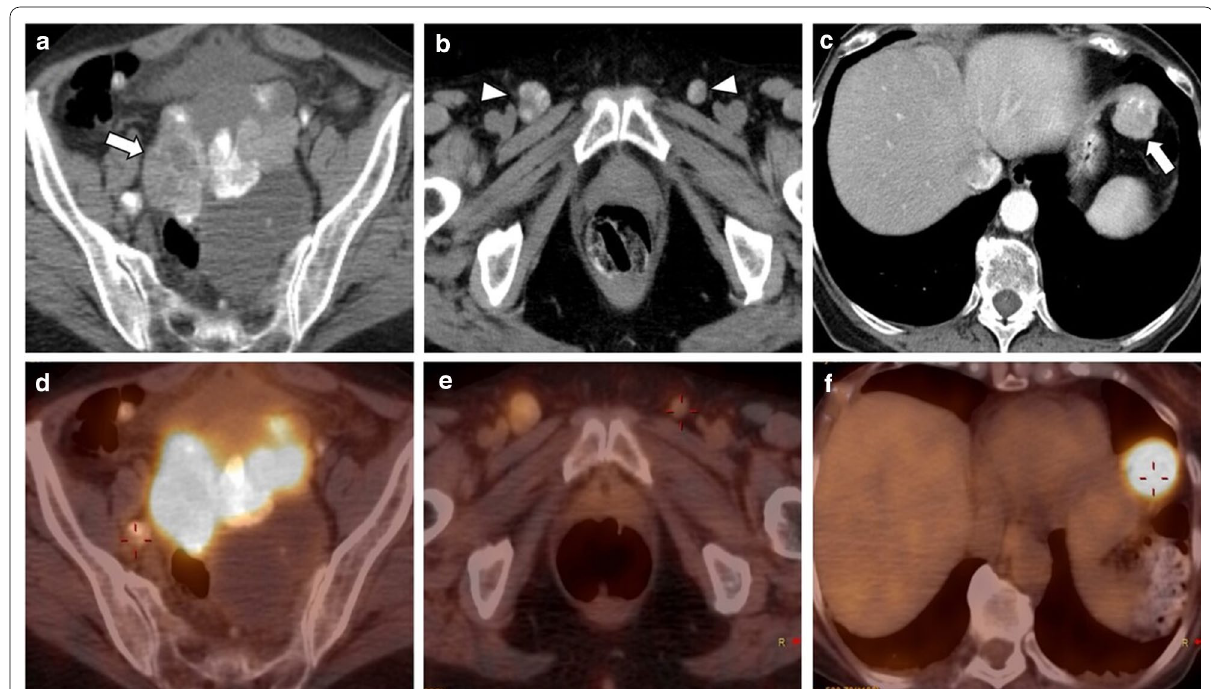
Fig. 8 Local recurrence of LGSC with peritoneal and lymph node metastases in a 74-year-old female. Axial unenhanced CT images display a large, heterogeneous, mixed tumour in the vaginal dome (arrow) ( a ) with bilateral inguinal lymph node metastases (arrowheads) ( b ), both with calcified psammoma bodies. Axial enhanced CT image reveals a peritoneal metastasis in the left hypochondrium peritoneum (arrow) ( c ). FDG-PET/CT images show a hypermetabolic pelvic lesion ( d ), bilateral inguinal lymphadenopathies ( e ) and a left upper hypochondrium peritoneal lesion ( f ), suggestive of